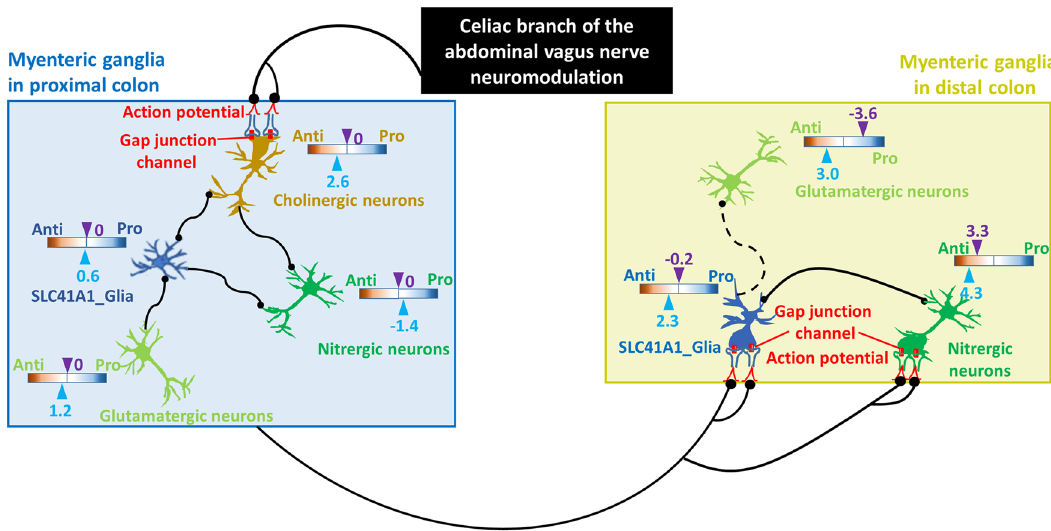
Fig. 9 Cartoon diagram illustrating potential electrical transmission along the proximal-distal axis of the porcine colon under vagal nerve stimulation (VNS) and the response mechanisms of certain neuronal/glial cell populations to VNS. The enrichment ratio of the shared biological processes (BPs) between the top fi ve WikiPathways and pro- or anti-in fl ammatory signaling (pro/anti) was calculated. The solid and dot lines represent cell – cell interactions with and without alterations under VNS, respectively. Black dots represent the targeting sites. Color represents a log10(pro/anti) distribution from Anti (orange) to Pro (blue). Arrowheads in light blue and purple indicate the enrichment ratio with and without VNS, respectively. Pro pro- in fl ammation, Anti anti-in fl